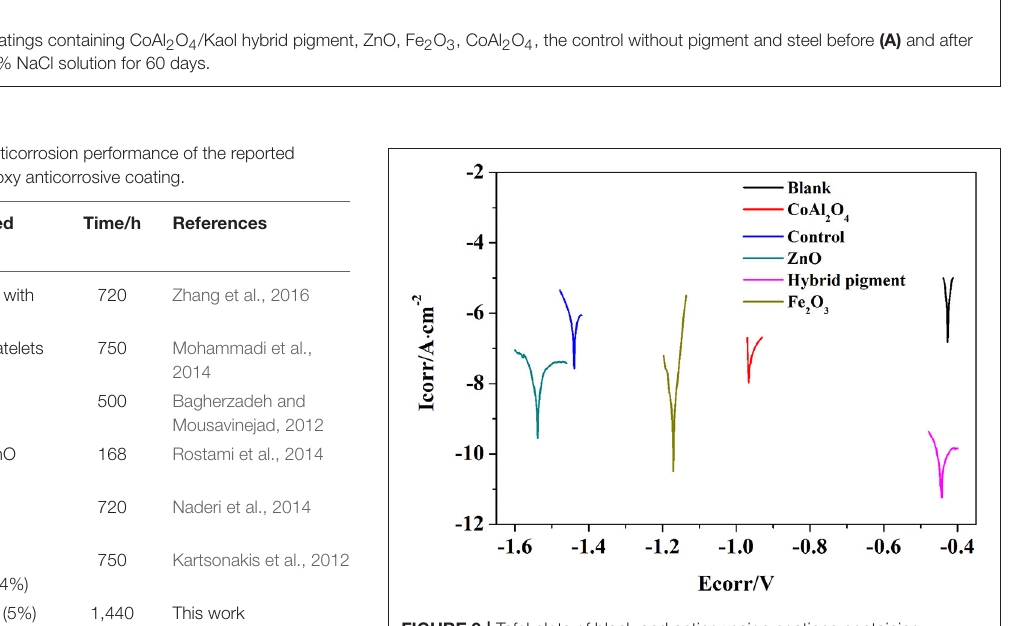
FIGURE 9 | Tafel plots of blank and anticorrosion coatings containing CoAl 2 O 4 calcined at 1,100 ◦ C, control without pigment, ZnO, CoAl 2 O 4 /hybrid pigment, and Fe 2 O 3 , respectively.